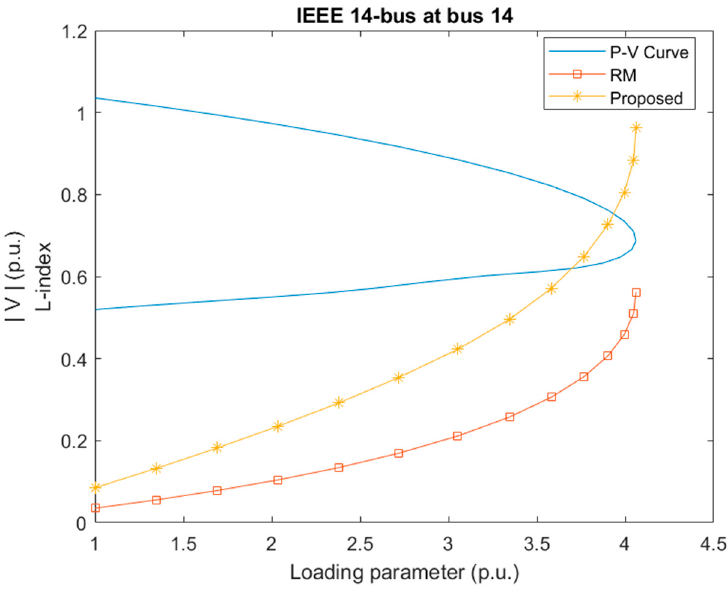
Figure 6. Comparison with L-index between the proposed method and the reference method (RM) at load bus 14 for IEEE 14-bus network.